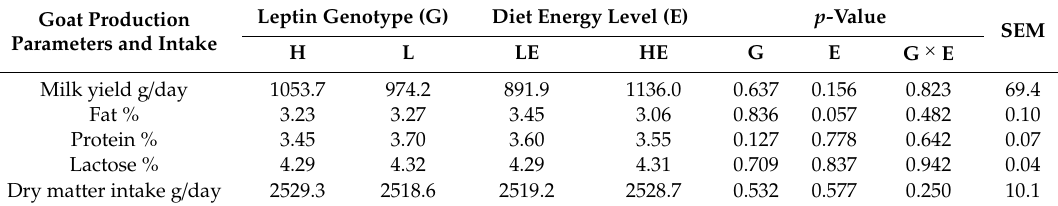
Table 2. E ff ects of leptin genotype and energy level of diet on milk yield and composition and dry matter intake.